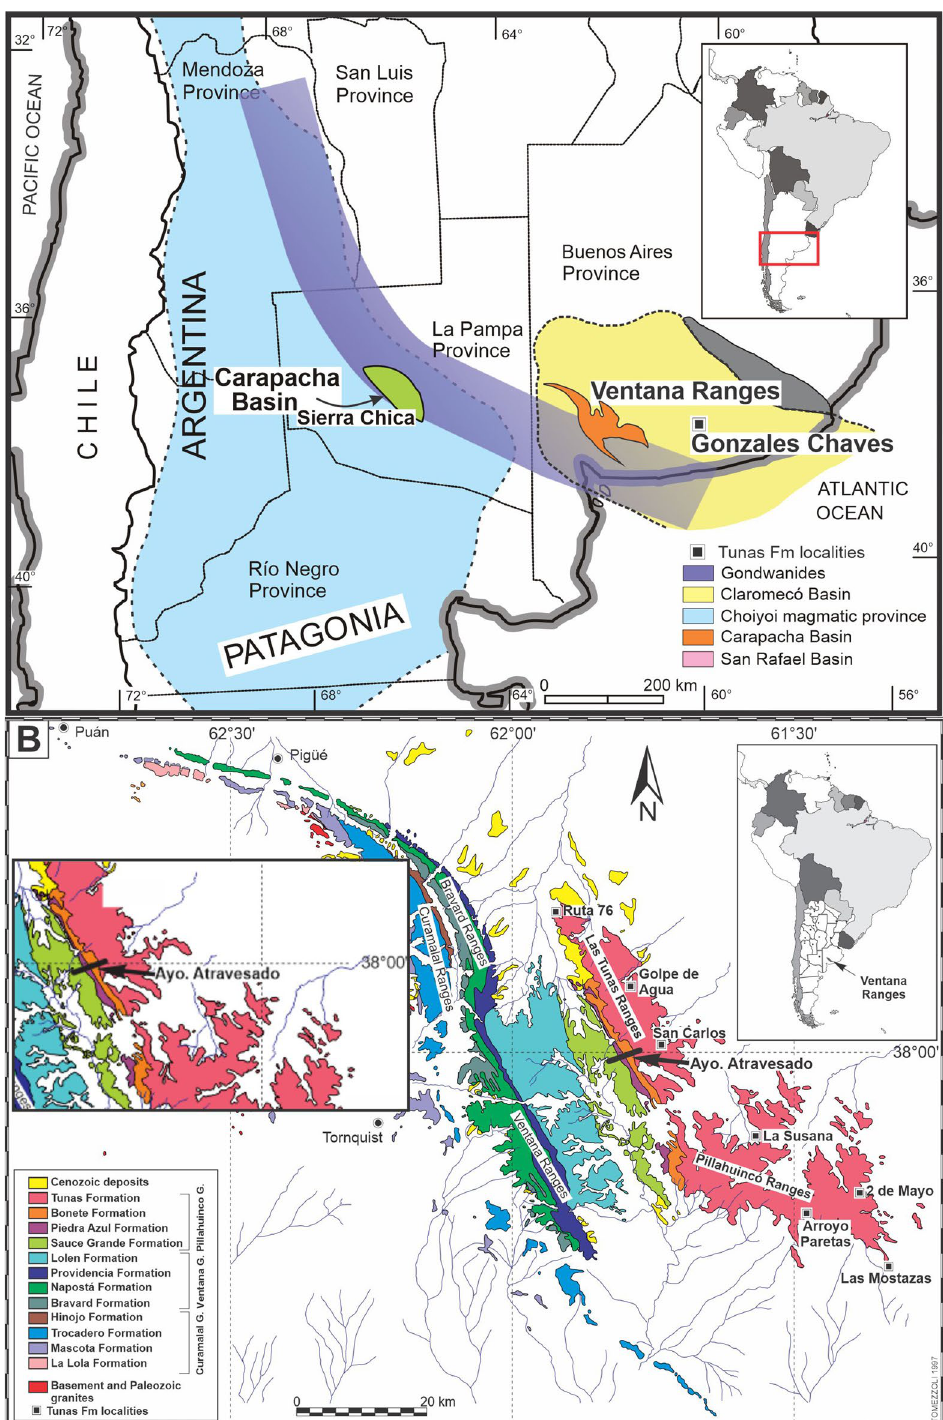
Figure 1. ( A ) Location of the Ventana Ranges thrust and fold belt in the southwest of Buenos Aires province, Argentina and others surroundings geological provinces (Carapacha Basin and Patagonia "terrain"). The study area is the exposed portion of the Claromecó Basin (in yellow) developed in the southwestern margin of the Gondwanides belt (in violet). ( B ) Geologic map of the Ventana Ranges modified from Suero 8 . Location of the Arroyo Atravesado log, where the samples were taken for the AMS studies. Up at the left: enlargement of the work area. The maps were generated and edited with Inkscape (https:// inksc ape. org/